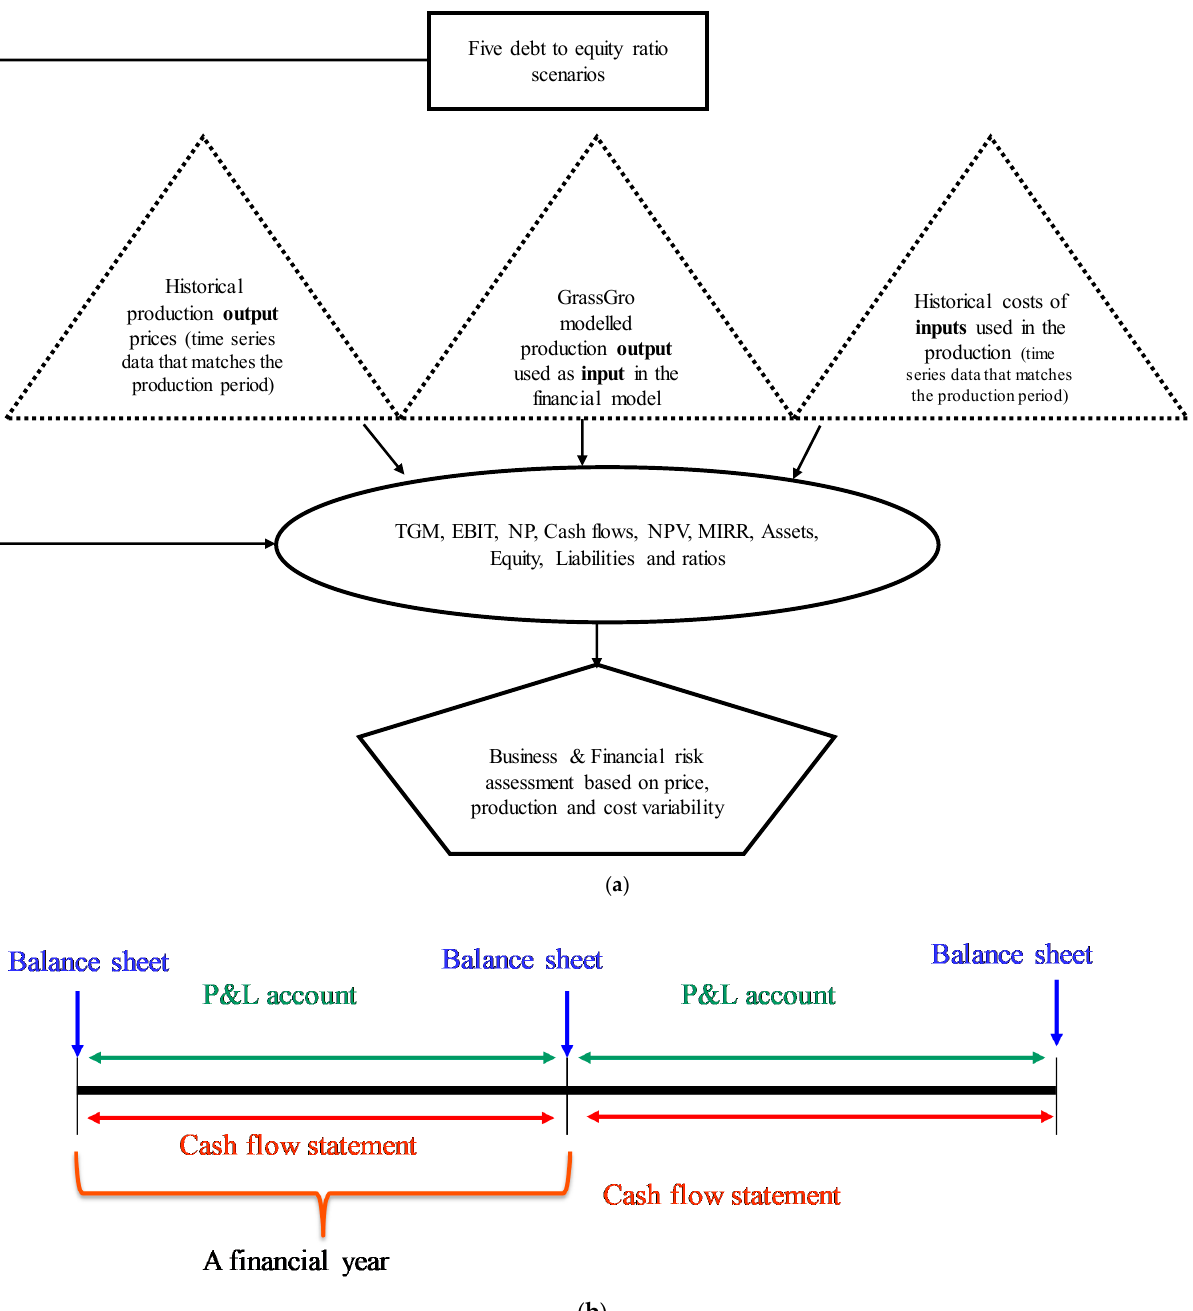
Figure 1. ( a ) Sheep farm risk assessment model. The diagram distinguishes between the following elements, each with its own shape: Decisions: Rectangle, Input parameters: dashed line triangles for volatility, Output: Oval, Objectives: Hexagon, Diagram idea source: Lehman and Groenendaal [18]. TGM is farm’s total gross margin, EBIT is earnings before interest and taxation, NP is net profit, NPV is net present value and MIRR is modified internal rate of return. ( b ) Interlinked financial statements.